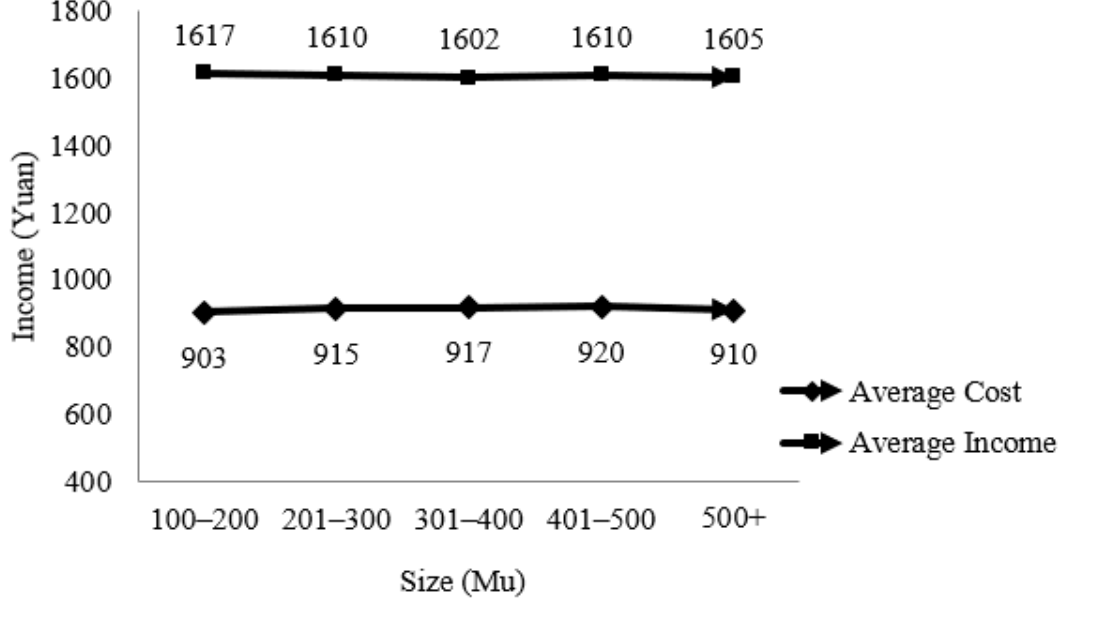
Figure 2. The cost of income for large-scale farming households.